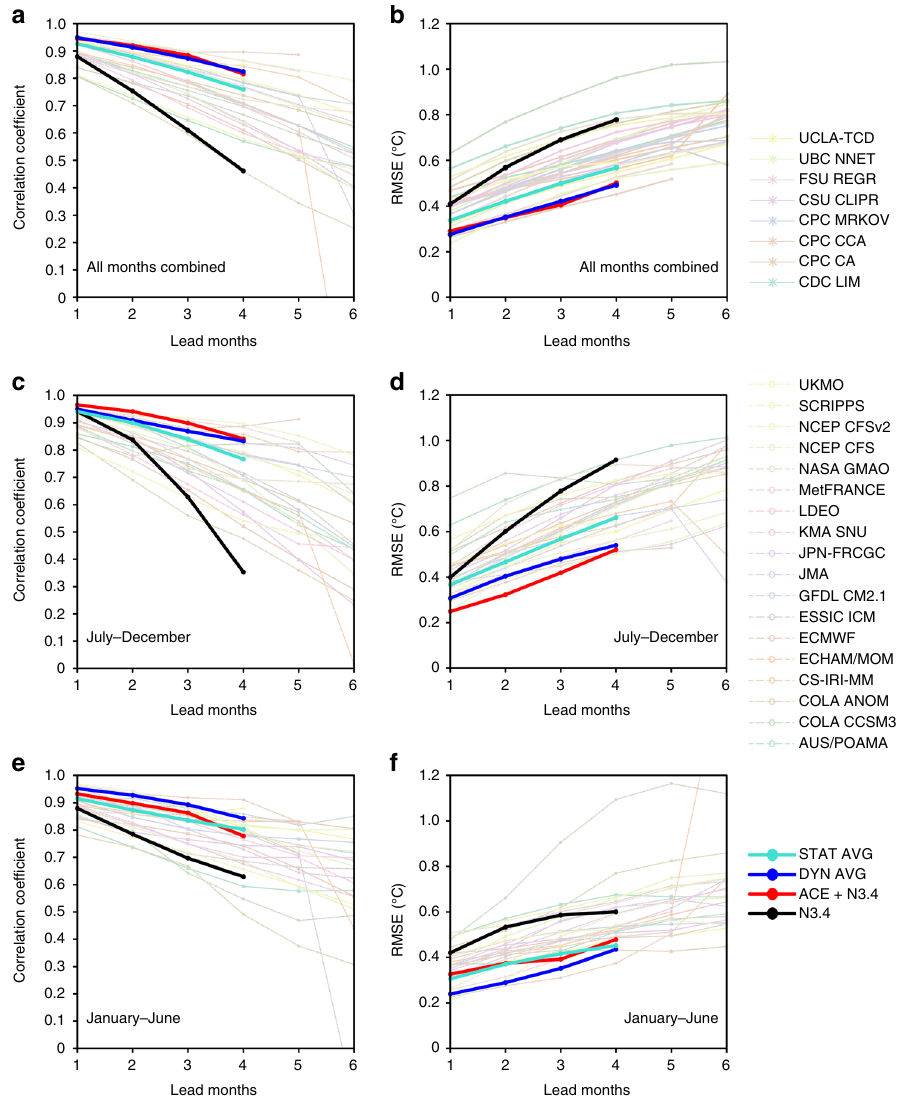
Fig. 8 Temporal correlation and root mean square error (RMSE, °C) between predictions and observations from 2002 to 2016, as a function of lead time. a Correlation coef fi cient for all months combined. Each line represents one model. Eighteen dynamical models (thin dashed lines with circles), eight statistical models (thin solid lines with asterisks), the N3.4 model (black thick line with dots) and the ACE + N3.4 model (red thick line with dots) are employed. The blue (turquoise) thick line with dots denotes the average of the dynamical (statistical) models. b Same as a , but for RMSE (°C). c Same as a , but for July – December. d Same as c , but for RMSE. e Same as a , but for January – June. f Same as e , but for RMSE climatic events. If this cumulative effect of short-term events can the year (January − December) that El Niño (La Niña) develops from weak to strong, and the El Niño (La Niña) decaying year is de fi ned when El Niño (La Niña) be reproduced well in the existing forecasting models, the pre- decays from strong to weak. Above-moderate El Niño (La Niña) events (including diction skill of models would be improved. Furthermore, we can moderate events) are de fi ned as when fi ve consecutive overlapping 3-month also apply this cumulative effect to cross-scale studies in other periods are at or above (below) the 1°C ( – 1°C) SST anomaly and the largest disciplines. For example, in oceanography, it may deepen our N3.4 index value occurs from October to January. Since 1970, 9 El Niño understanding of the inverse energy cascade from mesoscale eddies to large-scale circulation. All these aspects belong to the category of cross-scale dynamics, which deserves further in- depth study. this work, unless otherwise speci fi ed, El Niño developing years are the developing years of these nine El Niño events. To increase the reliability of our results, monthly composite and regression analyses are employed in this study. The Walker index = U 200 − U 850 , where U 200 and U 850 are the mean (5°S − 5°N, 120°W − 120°E) zonal wind anomalies at the 200- and 850-hPa levels, respectively.